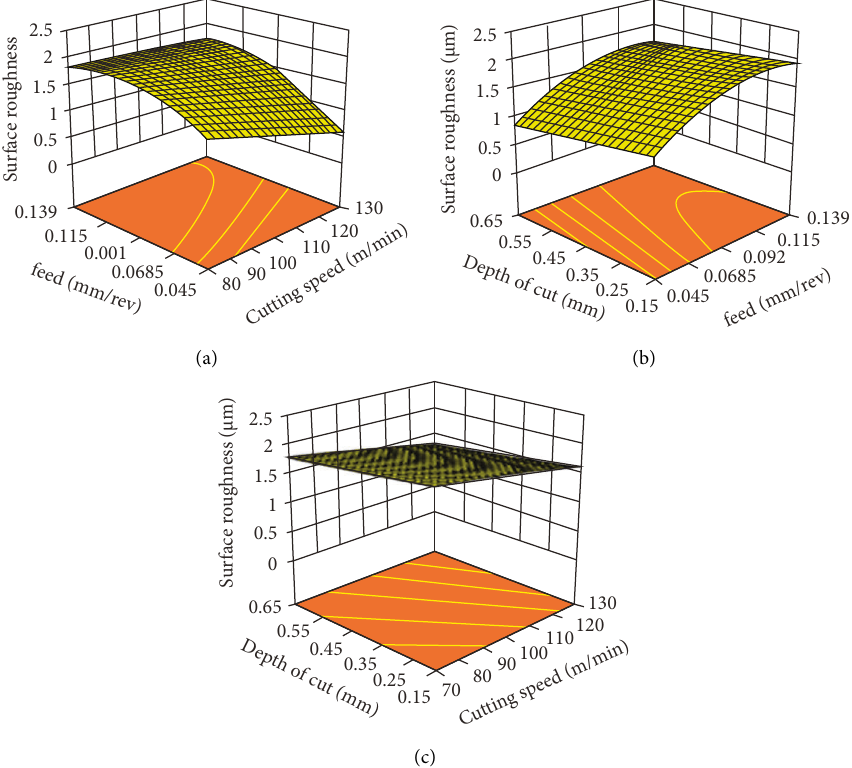
Figure 7: (a) Cutting speed Vs. feed, (b) feed Vs. depth of cut, and (c) cutting speed Vs. depth of cut.